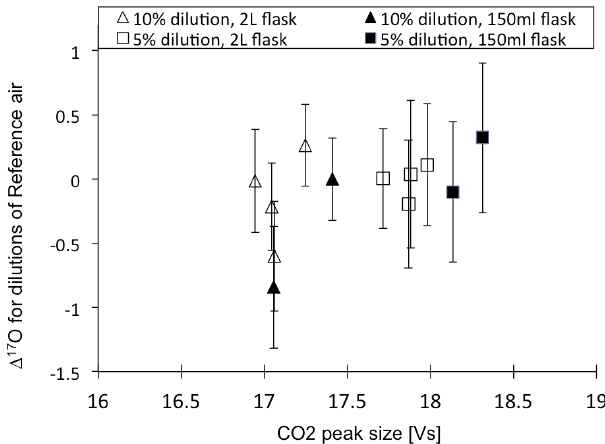
Figure 8. (cid:49) 17 O of CO 2 in aliquots of the laboratory reference gas that was filled into flasks of 2L and 150mL volume, respectively. These are the flasks in which the stratospheric samples were mea- sured. The reference air was additionally diluted by 5% (squares) or 10% (triangles) with zero air. There is no significant difference between different types of flask, and for the different dilutions, thus no non-linearity can be detected.